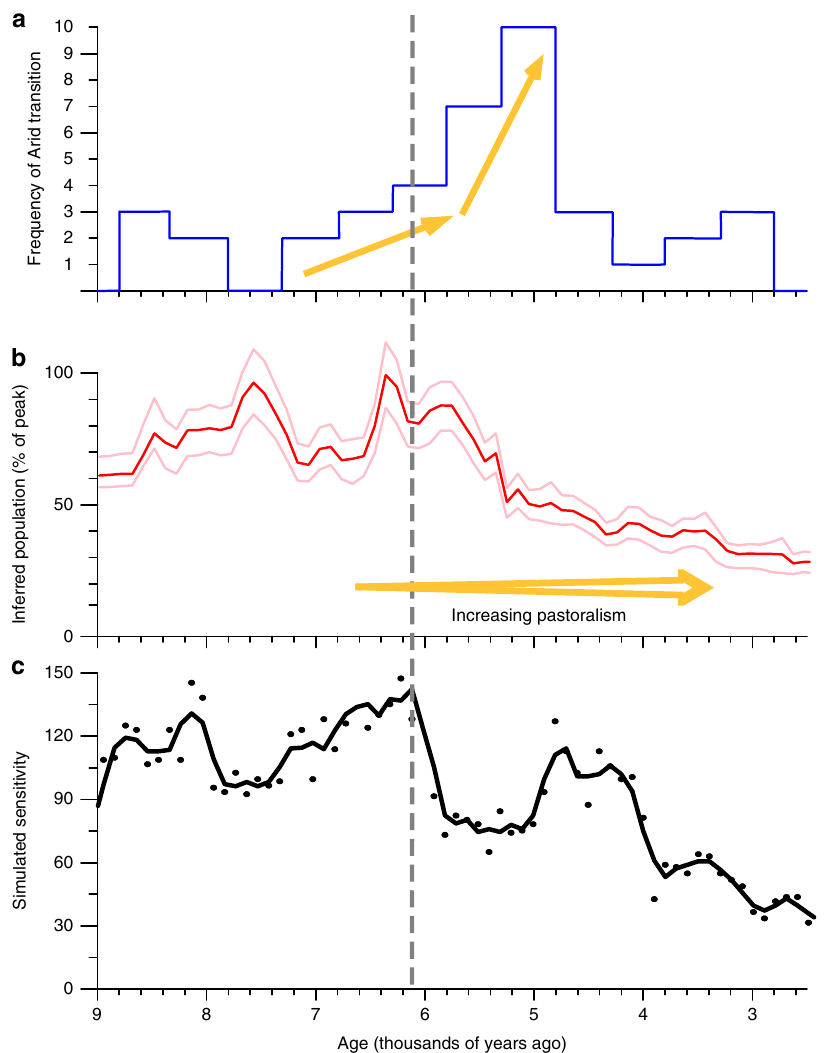
Fig. 5 Potential interaction between humans and the ecosystem during the end of the African humid period. a Histogram of the number of climate proxies (Fig. 1a) indicating an end of the African Humid Period within a 500 year window 3 . b The population inferred summed probability distribution 22 over the whole of northern Africa region along with its 5 – 95% con fi dence level. c The simulated sensitivity of northern Africa diagnosed from the model. Black dots show the number of not-implausible model settings with a threshold time, t ∗ , in each century (see Methods for details); the black line is a 3 point running average. The gray line vertical indicates the time of the maximum simulated